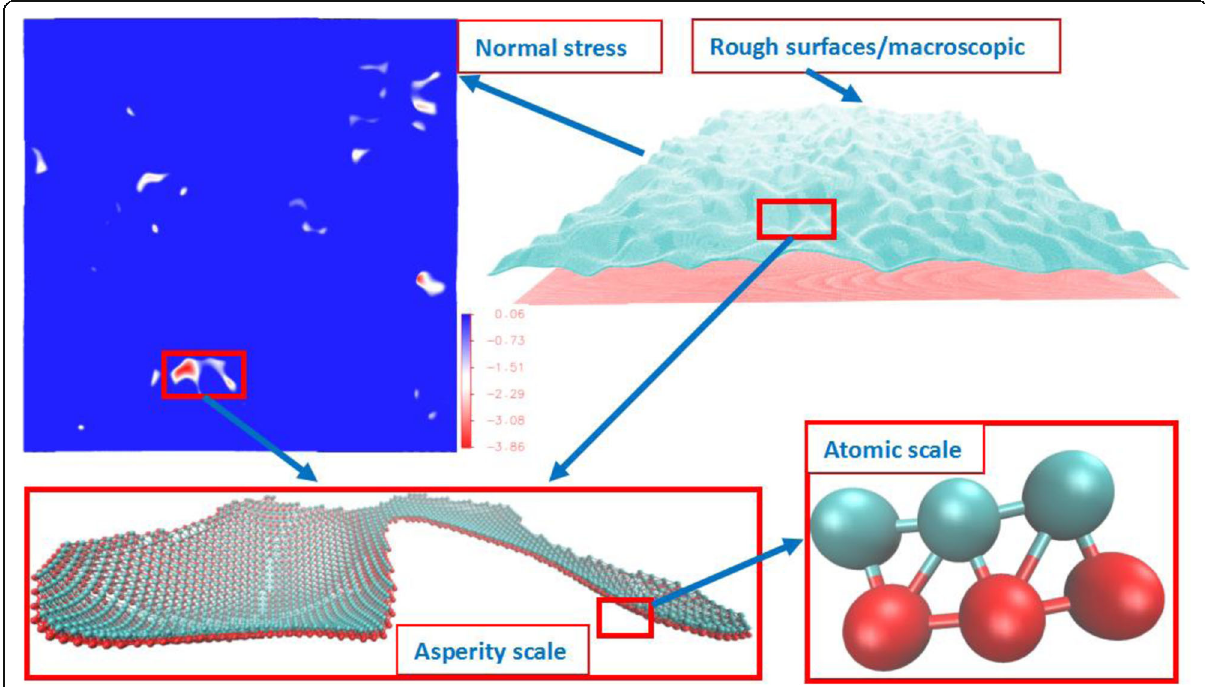
Fig. 1 The GFMD model at different scales, from atomic scale to macroscopic scale (in σ